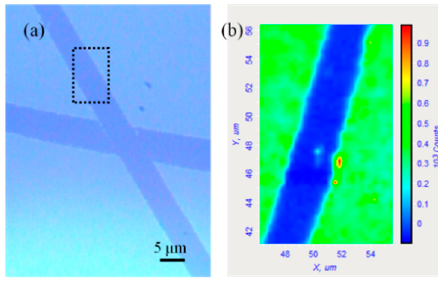
Figure 3. ( a ) The morphology of EG under optical microscopy. ( b ) Raman mapping of 2D-band measured from the dashed black rectangle region in ( a ).